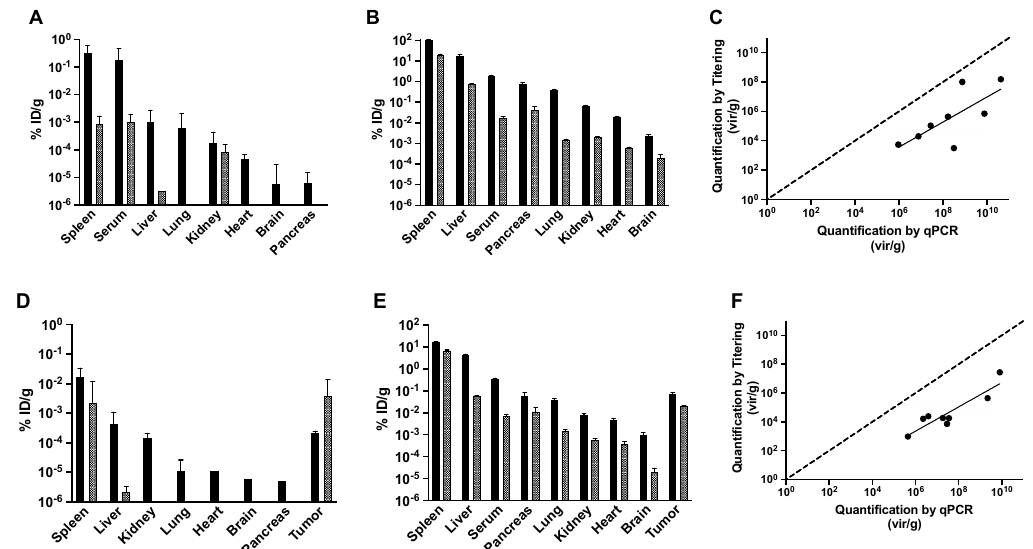
Figure4. Quantificationofphagesinmousetissues. Phageconcentrations, representedasthepercentage Figure 4. Quantification of phages in mouse tissues. Phage concentrations, represented as the of injected dose recovered per gram of tissue (%ID / g), from isolated tissues after administration of a high percentage of injected dose recovered per gram of tissue (%ID/g), from isolated tissues after dose of f8 / 9 library in ( A – C ) non-tumor bearing NCR-nu / nu mice as compared with ( D – F ) NCR-nu / nu mice bearing an MDA-MB-231 breast cancer xenograft. Biological titering of phages in E. coli cells ( A , D ) or physical quantification of phages by qPCR ( B , E ) after 1 hour (black, solid bars) or 24 hours (grey, hashed bars) of circulation. Bar charts display the mean ± standard deviation of technical replicates for each tissue [ N ≈ 3] from a single representative mouse. Mean phage concentrations (vir / g) from matched tissue samples were plotted ( C , F ) and a linear regression model was fit for tissues recovered from an individual mouse after 1 hour